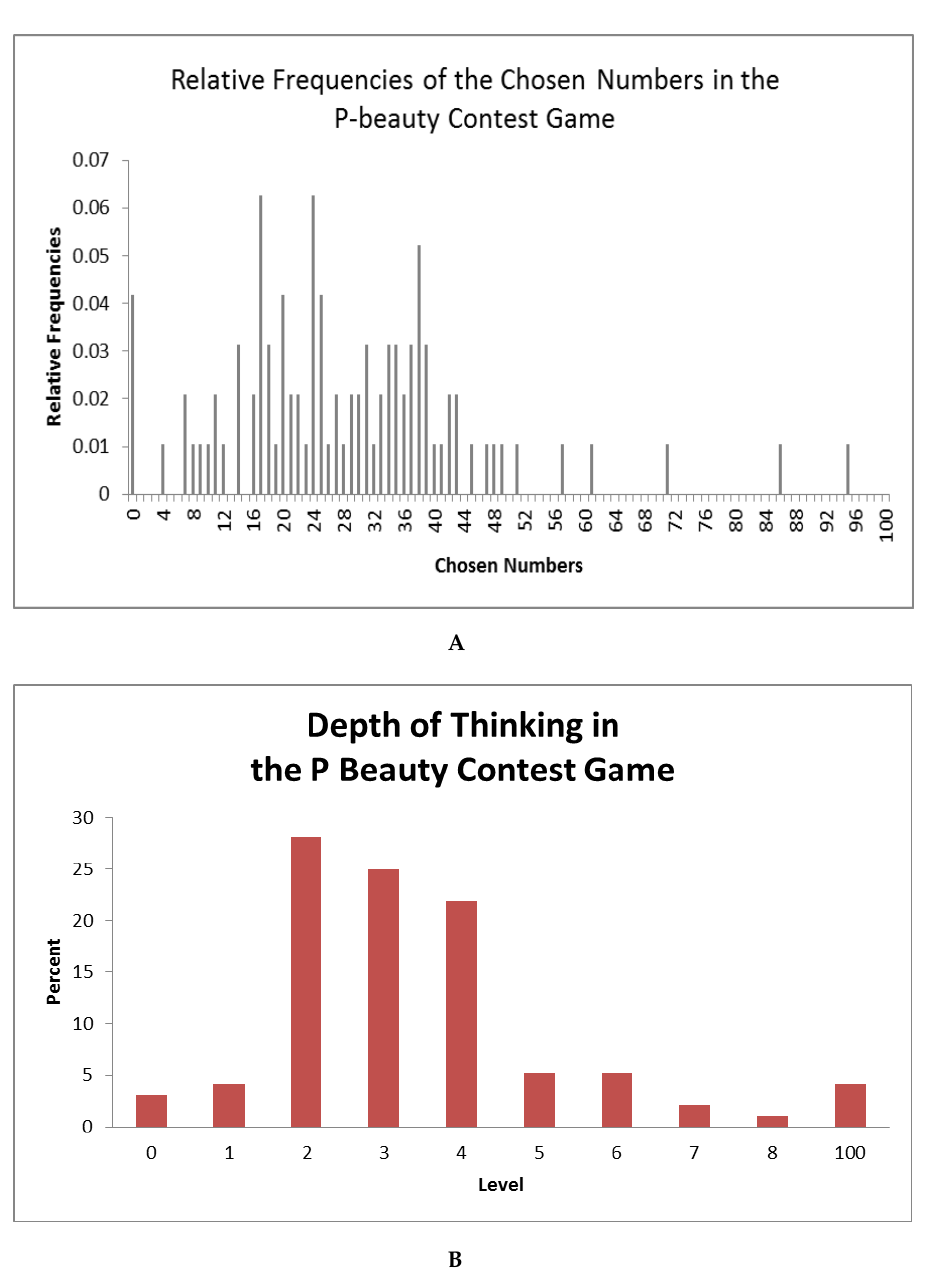
Figure 2. The Relative Frequencies of the Chosen Numbers and the Depth of Thinking in the P Beauty Contest Game. ( A ) The Relative Frequencies of the Chosen Numbers in the P-beauty Contest Game; ( B ) The Depth of Thinking in the P Beauty Contest Game.